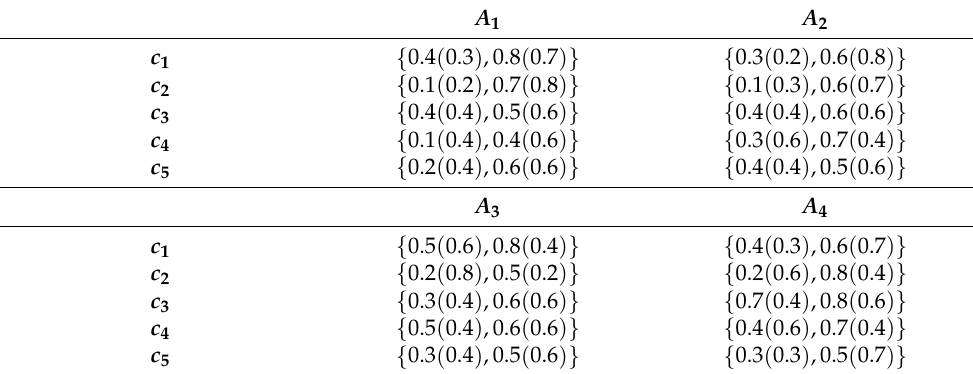
Table 6. Standardized evaluation matrix of Expert 3 ( d 3